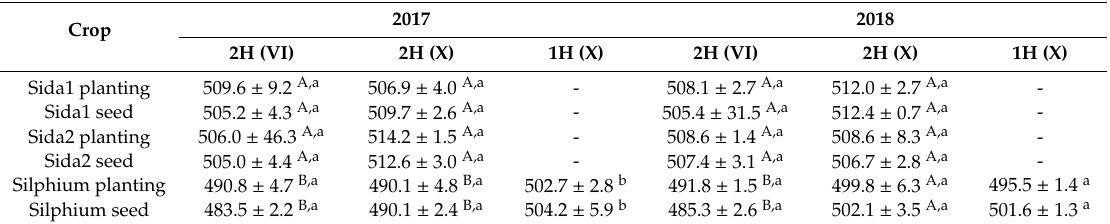
Table 2. Mean values of specific biogas yield (SBY) of the analysed crops biomass, L kg DM − 1 .